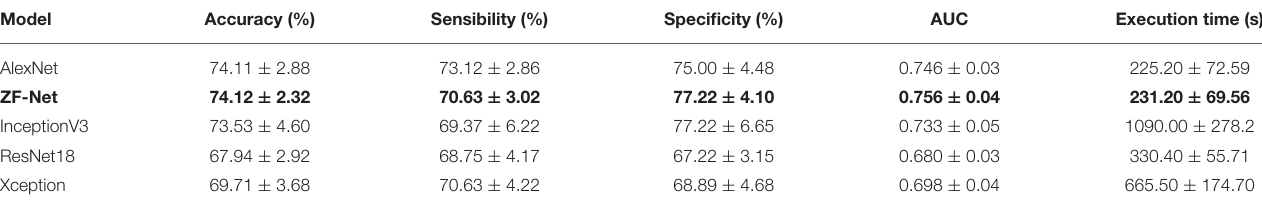
TABLE 2 | Performance of different classification approaches in mutiltasking classification.